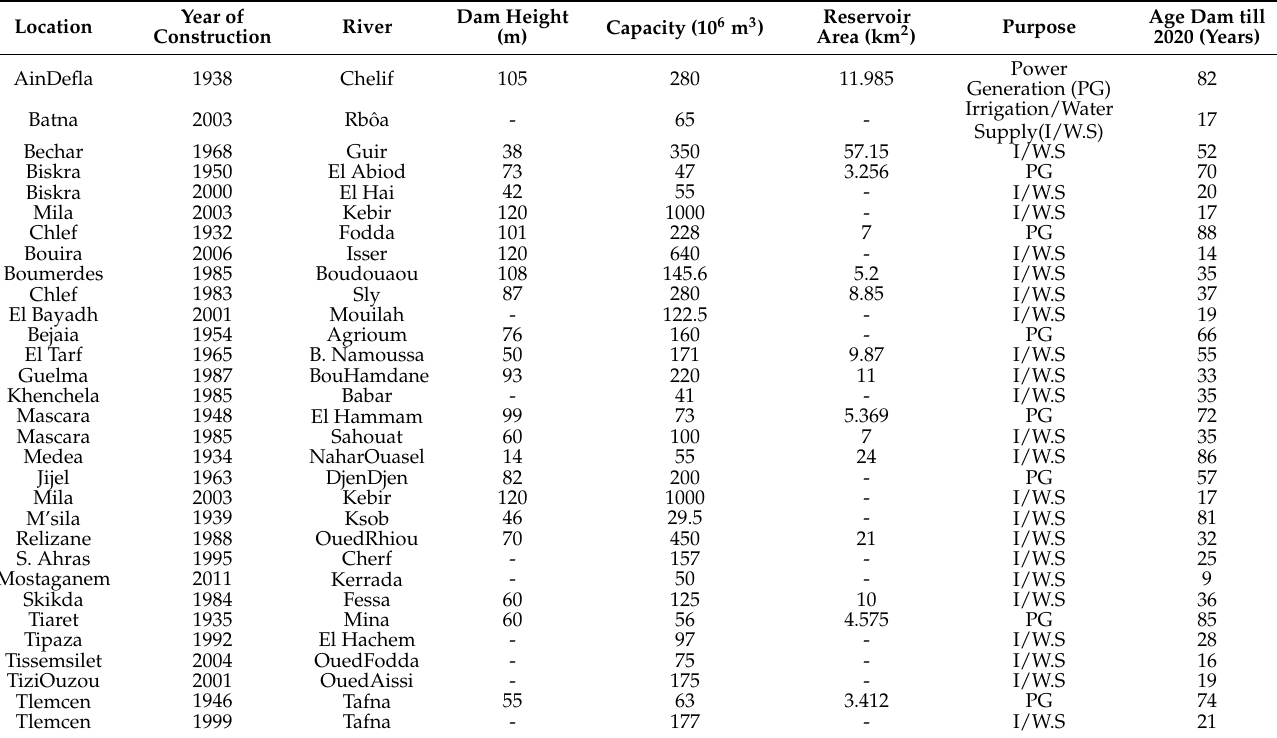
Table 5. Details of dams implanted in Algeria.